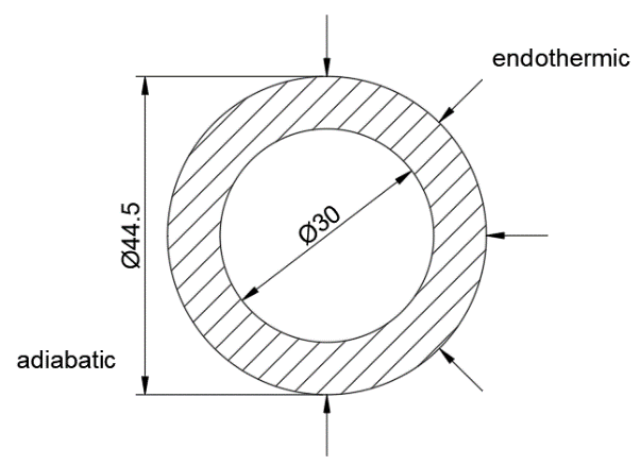
Figure 4. Section diagram of the upper vertical tube.